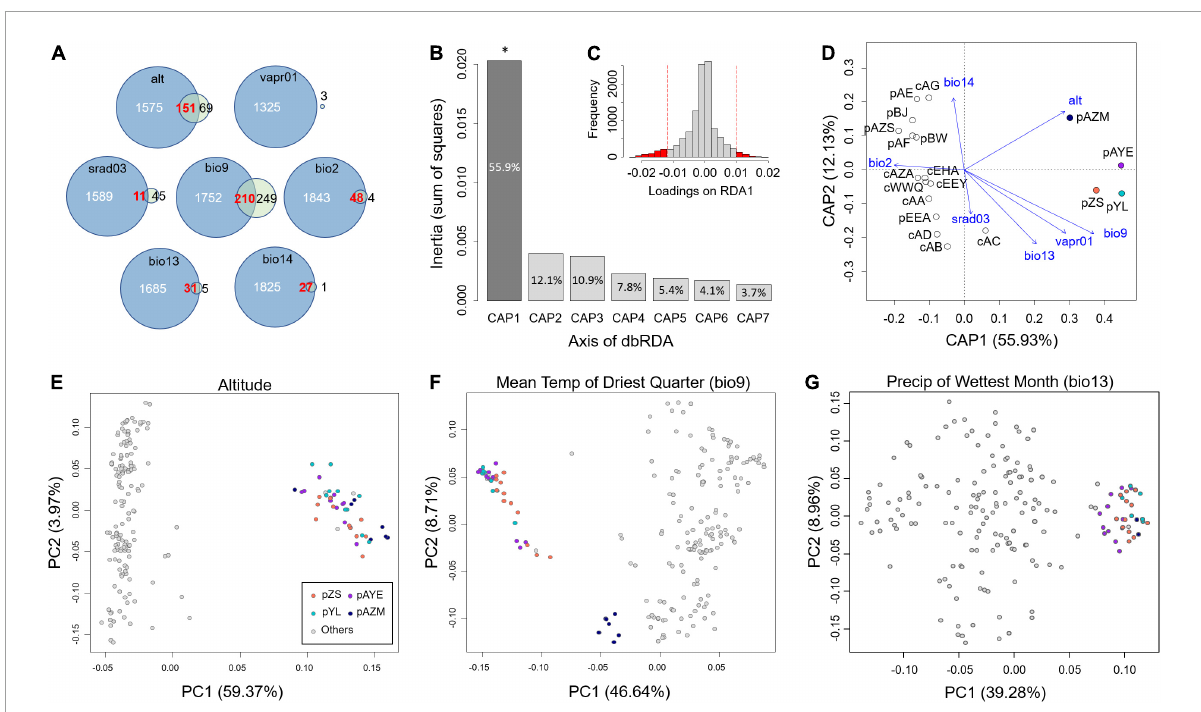
FIGURE6 Determination of the driver of local adaptation. (A) The intersection of putative adaptive SNPs inferred by LFMM (blue circles) and dbRDA (green circles). The values denote the estimated number of adaptive SNPs. (B) The explanatory proportion of each axis of the dbRDA, where only the 1st axis (CAP1) has a significant effect. (C) The distribution of SNP loadings on the 1st axis of the dbRDA. Red vertical lines denote the threshold of 95% confidence intervals to determine outliers (i.e., putative adaptive SNPs). (D) Scatter plot of the seven climatic parameters in the space of the first two axes of the dbRDA. (E–G) PCA scatterplots of the adaptive SNPs associated with environmental factors, including (E) altitude, (F) bio9, and (G) bio13, inferred by the intersection of the dbRDA and LFMM. The four coloured populations are the inferred adaptive peripheral